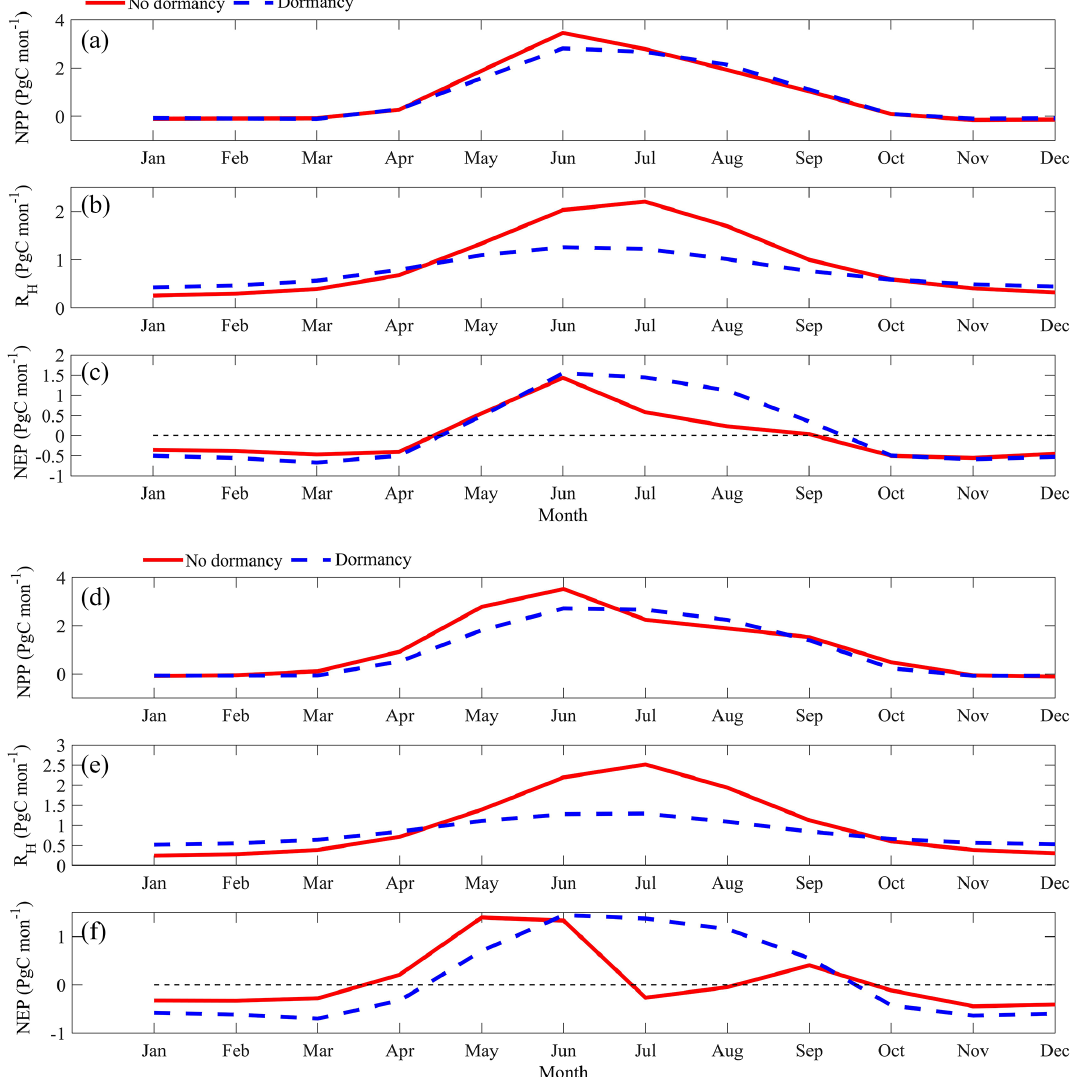
Figure 10. Regional annual seasonal pattern of simulated net primary production (NPP, a, d ), heterotrophic respiration ( R H , b, e ), and net ecosystem production (NEP, c, f ) during the 2090s from the dormancy model and MIC-TEM under (a, b, c) the RCP2.6 scenario and (d, e, f) the RCP8.5 scenario. The region is all land areas north of 45 ◦